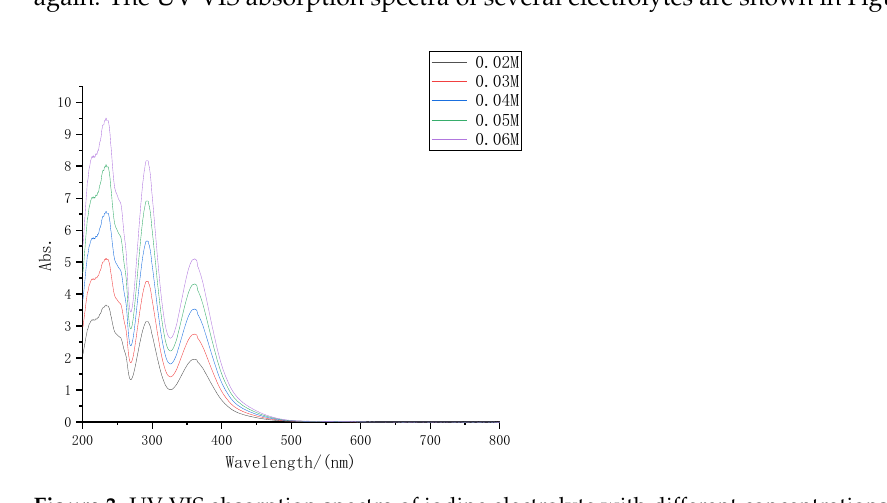
Figure 3. UV-VIS absorption spectra of iodine electrolyte with different concentrations .